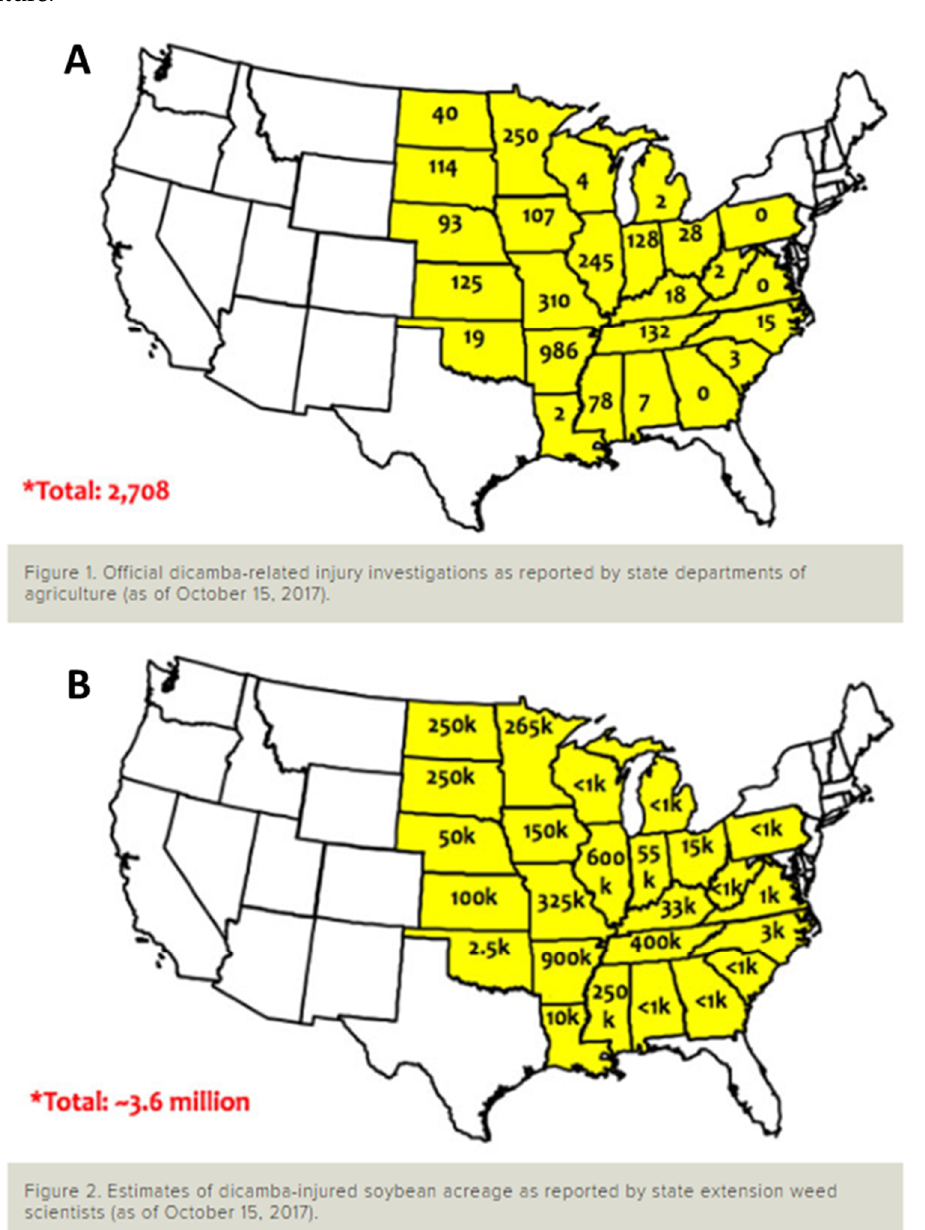
Figure 1. Official dicamba-related injury investigations as reported by state departments of agriculture ( A ) and estimates of dicamba-injured soybean acreage as reported by state extension weed scientists ( B ) in the 2017 growing season in the US.